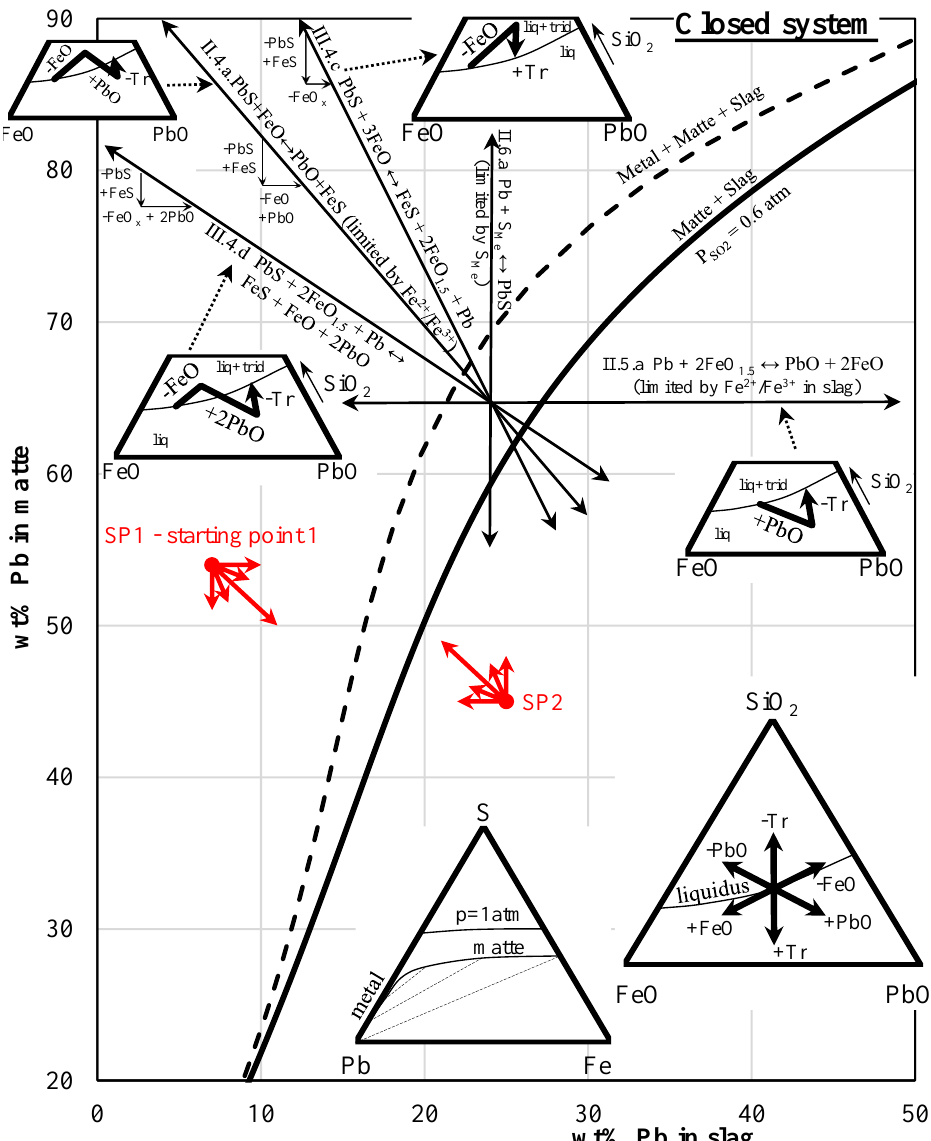
Figure 5. The compositional change direction diagrams for Pb matte vs. Pb slag and PbO-“FeO”-SiO 2 with the vectors showing the directions of the compositional changes in matte and slag phases for reactions in the closed system.